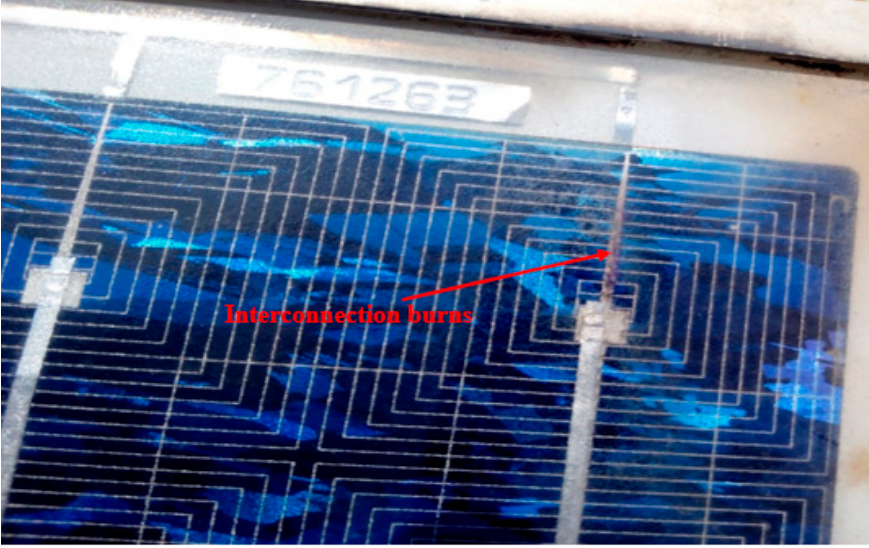
Figure 6. Module 10, indicating interconnection burns.